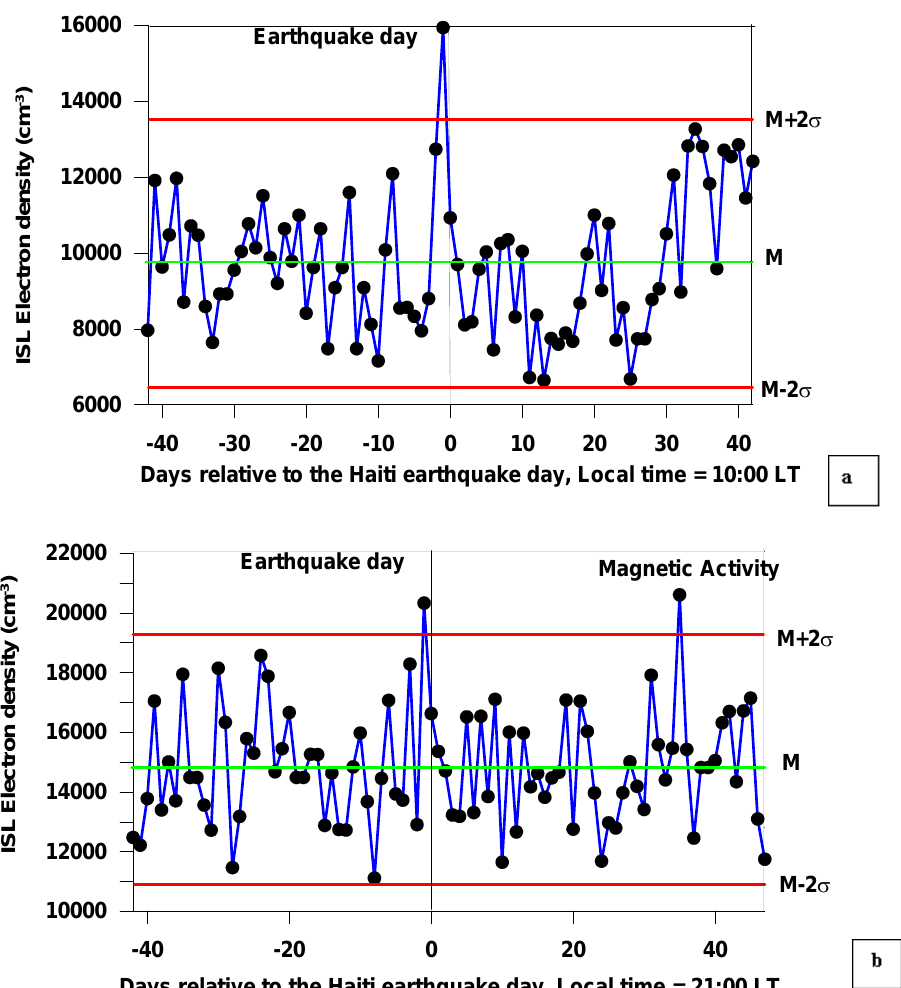
Fig. 2. Results of DEMETER analysis for Haiti earthquake from December 2009 to February 2010. Earthquake day is represented as vertical dotted line. The red horizontal lines indicate the upper and lower bounds. The green horizontal line indicates the mean value (M). The x-axis represents the day relative to the earthquake day. The y-axis represents (a) electron density derived by the measurements of the ISL experiment during daytime and (b) electron density derived by the measurements of the ISL experiment during